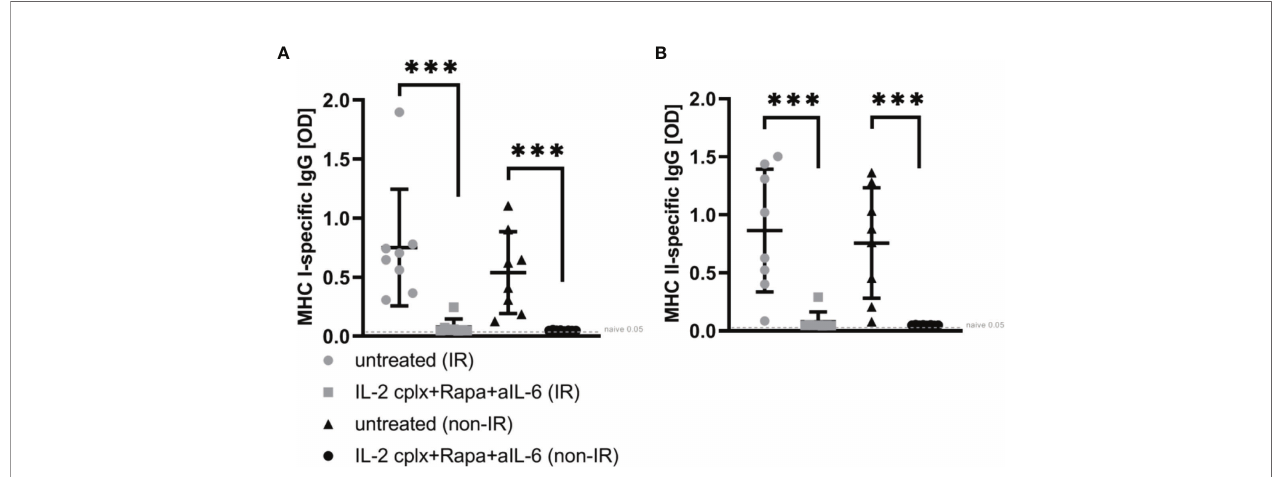
FIGURE 5 | ELISA for donor-speci fi c antibodies within blood sera 14 days post skin graft rejection. Irradiated (IR) or non-irradiated (non-IR) skin allograft recipients (C57BL/6) were either left untreated or IL-2 complexes in combination with rapamycin and anti-IL-6 (short term) were administered. Blood sera isolation was performed d14 post rejection of BALB/c skin allograft and assessment of donor speci fi c IgG (IgG1, IgG 2a/b, IgG3) against (A) MHC class I (H2k-d) and (B) MHC class II (IA-d) was done utilizing ELISA. Mean percentages of at least two independent experiments are shown. Error bars indicate SD. (***p < 0.001; two-tailed t test with unequal variances) (untreated (IR): n = 8; untreated (non-IR): n = 8; IL-2cplx protocol (IR): n = 8; IL-2cplx protocol (non-IR): n =